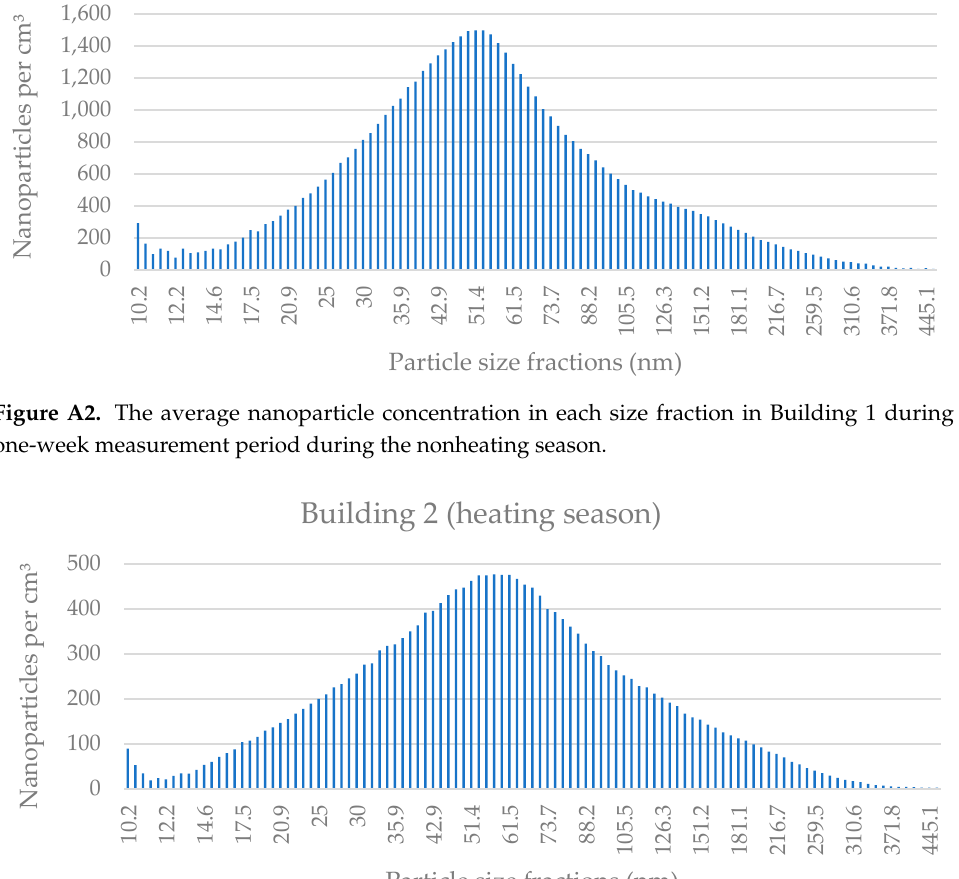
Figure A1. The average nanoparticle concentration in each size fraction in Building 1 during a one- week measurement period during the heating season.